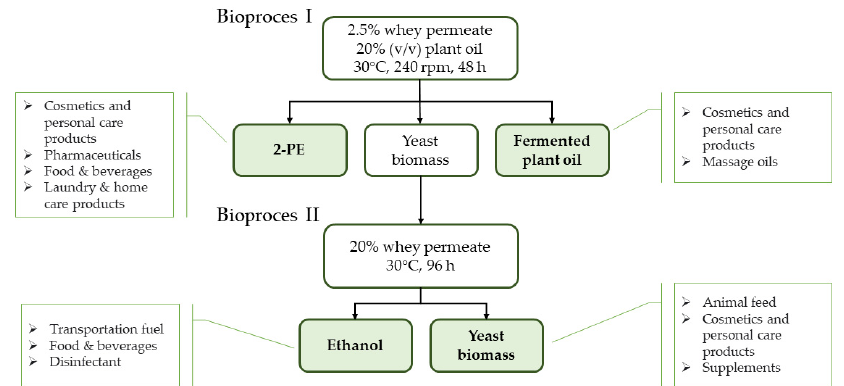
Figure 1. Conceptual diagram of the whey permeate valorisation process.